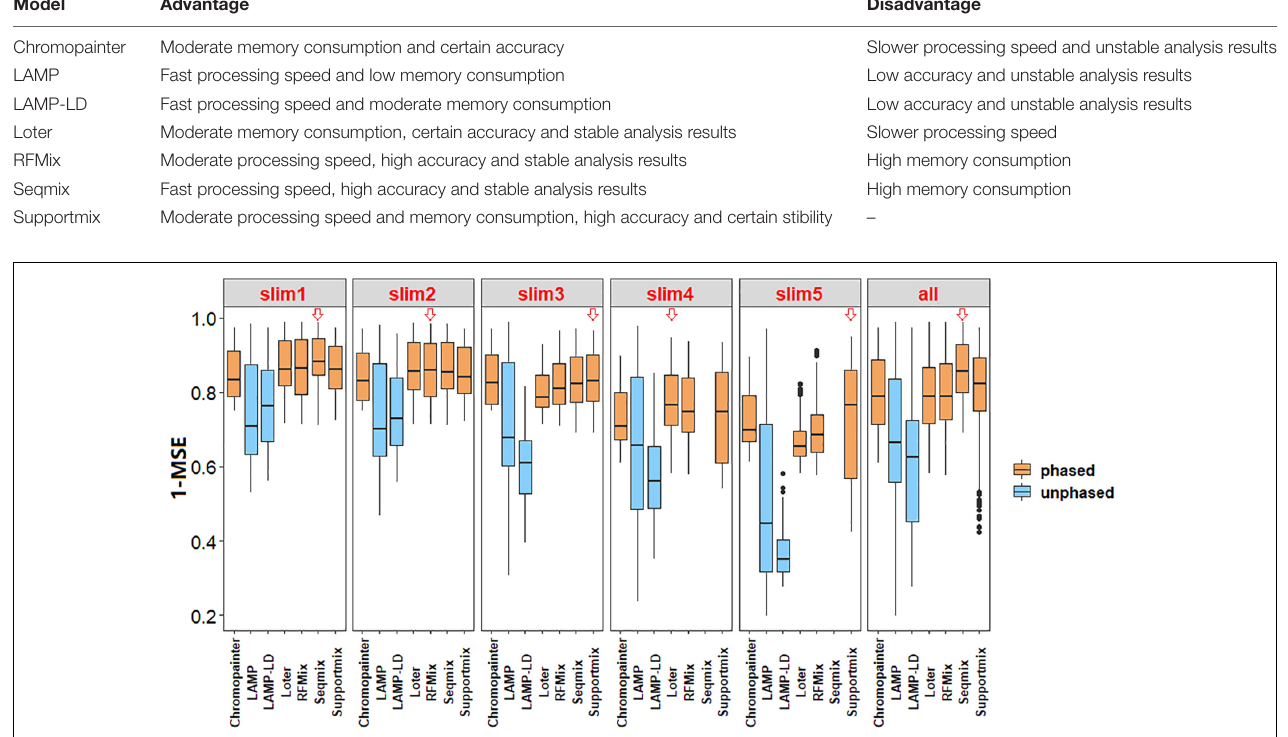
FIGURE 2 | Box plots of the accuracy of local ancestry inference (LAI) using a benchmark. The red hollow arrows indicate a higher accuracy by the median comparison in this simulation. The results showed that phased data had higher accuracy in comparison with unphased data.